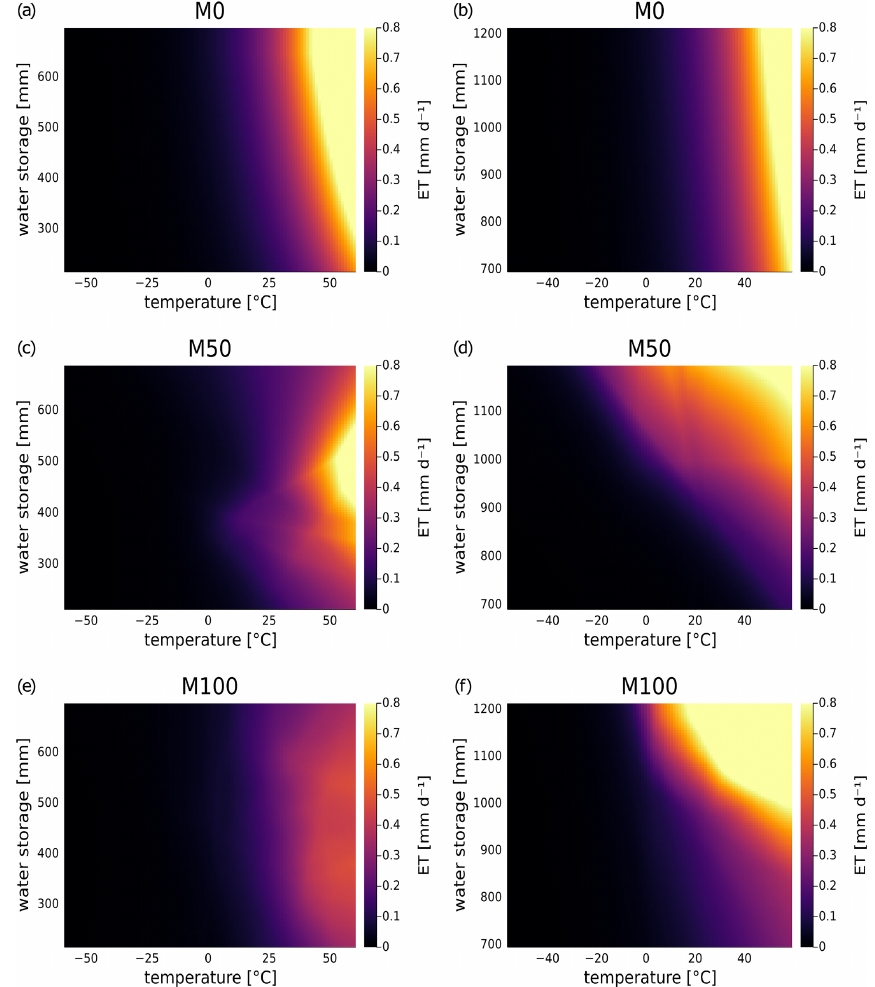
Figure 6. Dependence of evapotranspiration on temperature and water storage for neural ODE models M0, M50 and M100 in basin 1013500 (left; a , c and e , respectively) and in basin 6431500 (right; b , d and f , respectively). For NN 50 input snow storage was fixed at 0 in both basins, and precipitation for NN 100 was fixed at the average over the training period (3mmd − 1 for basin 1013500 and 1.9mmd − 1 for basin